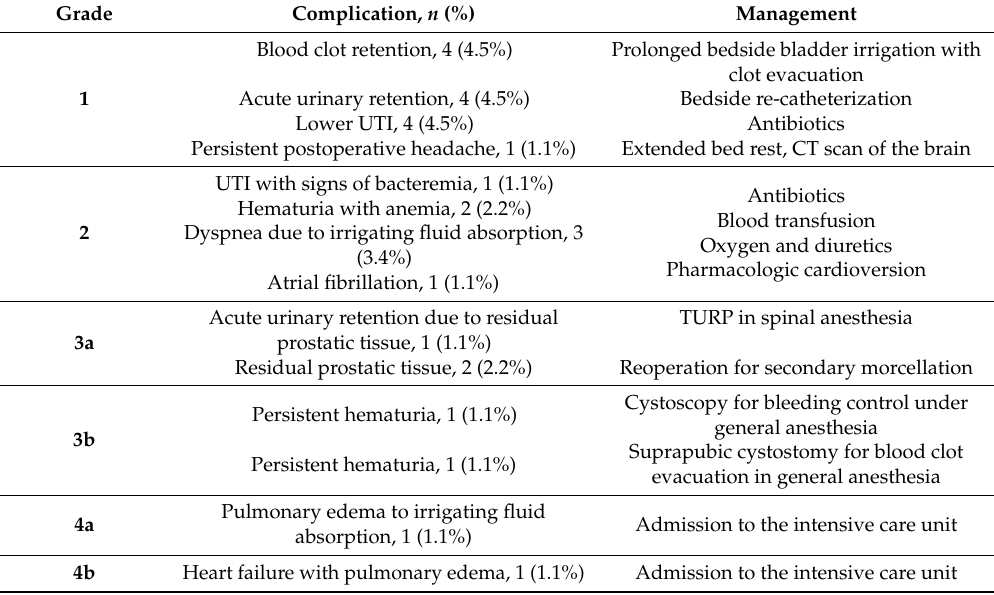
Table 2. Early complications and their management according to the modified Clavien classification system